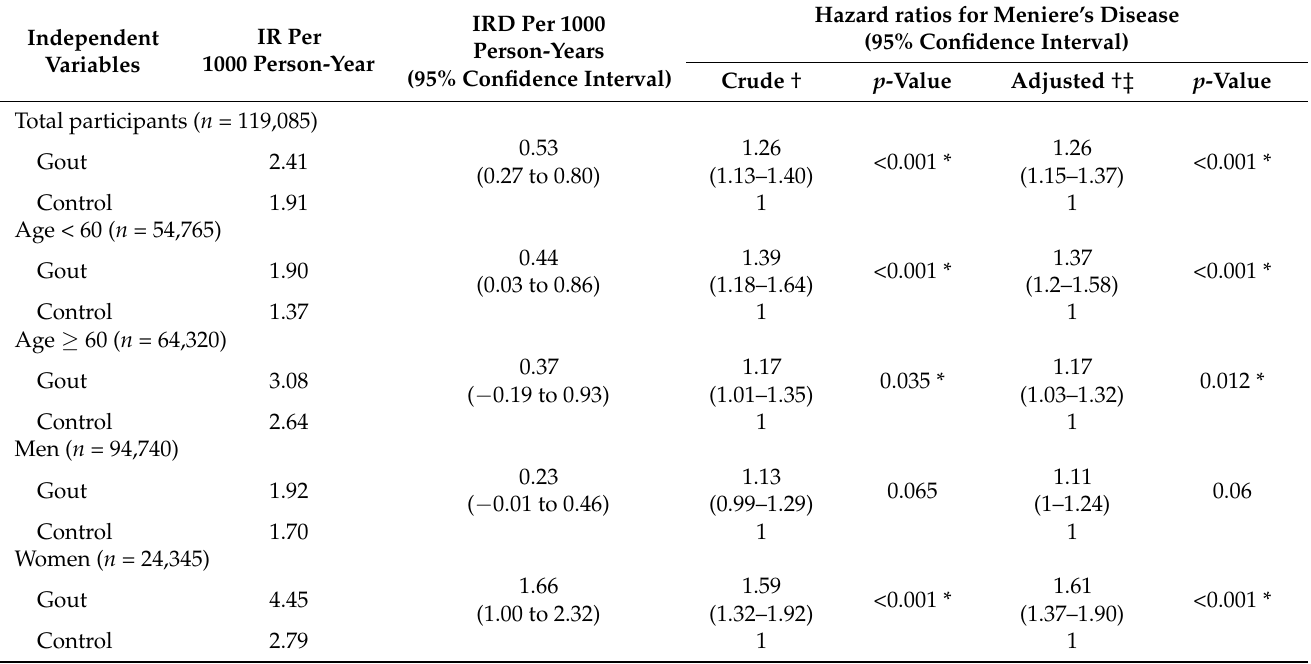
Table 3. Crude and adjusted hazard ratios of Gout for Meniere’s disease with subgroups according to age and sex with subgroups according to age, sex, obesity, and fasting blood